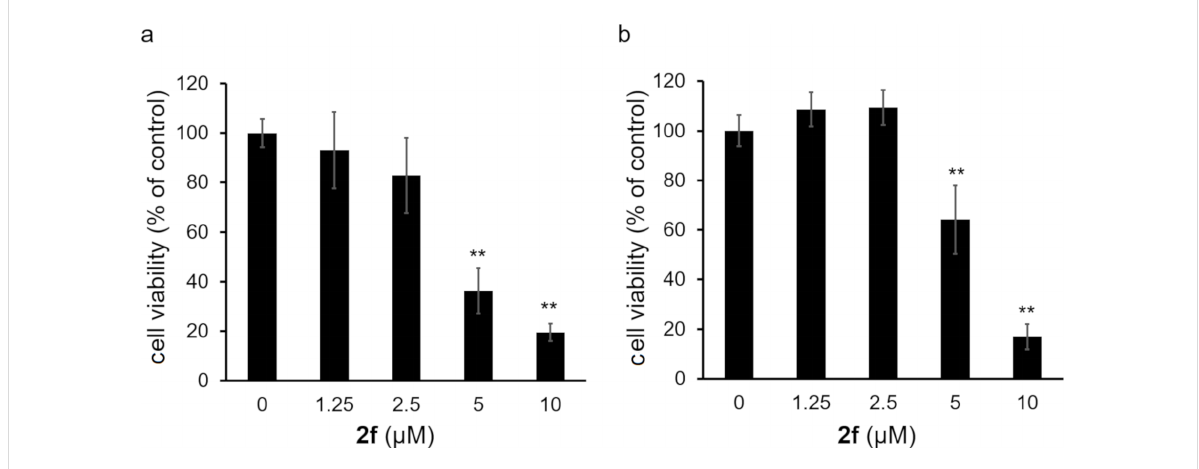
Figure 6: The cytotoxic effect of the bis[2-(4-methoxyphenyl)imidazo[1,2- a ]pyridin-3-yl] diselenide 2f on cancer cell lines. Human glioblastoma U251 cells (a) and human malignant meningioma HKBMM cells (b) were exposed to compound 2f for 24 h. The cell viability was confirmed by MTT assays. The data are represented as mean ± SD values of four samples. ** p < 0.01 compared to the control (no 2f present).